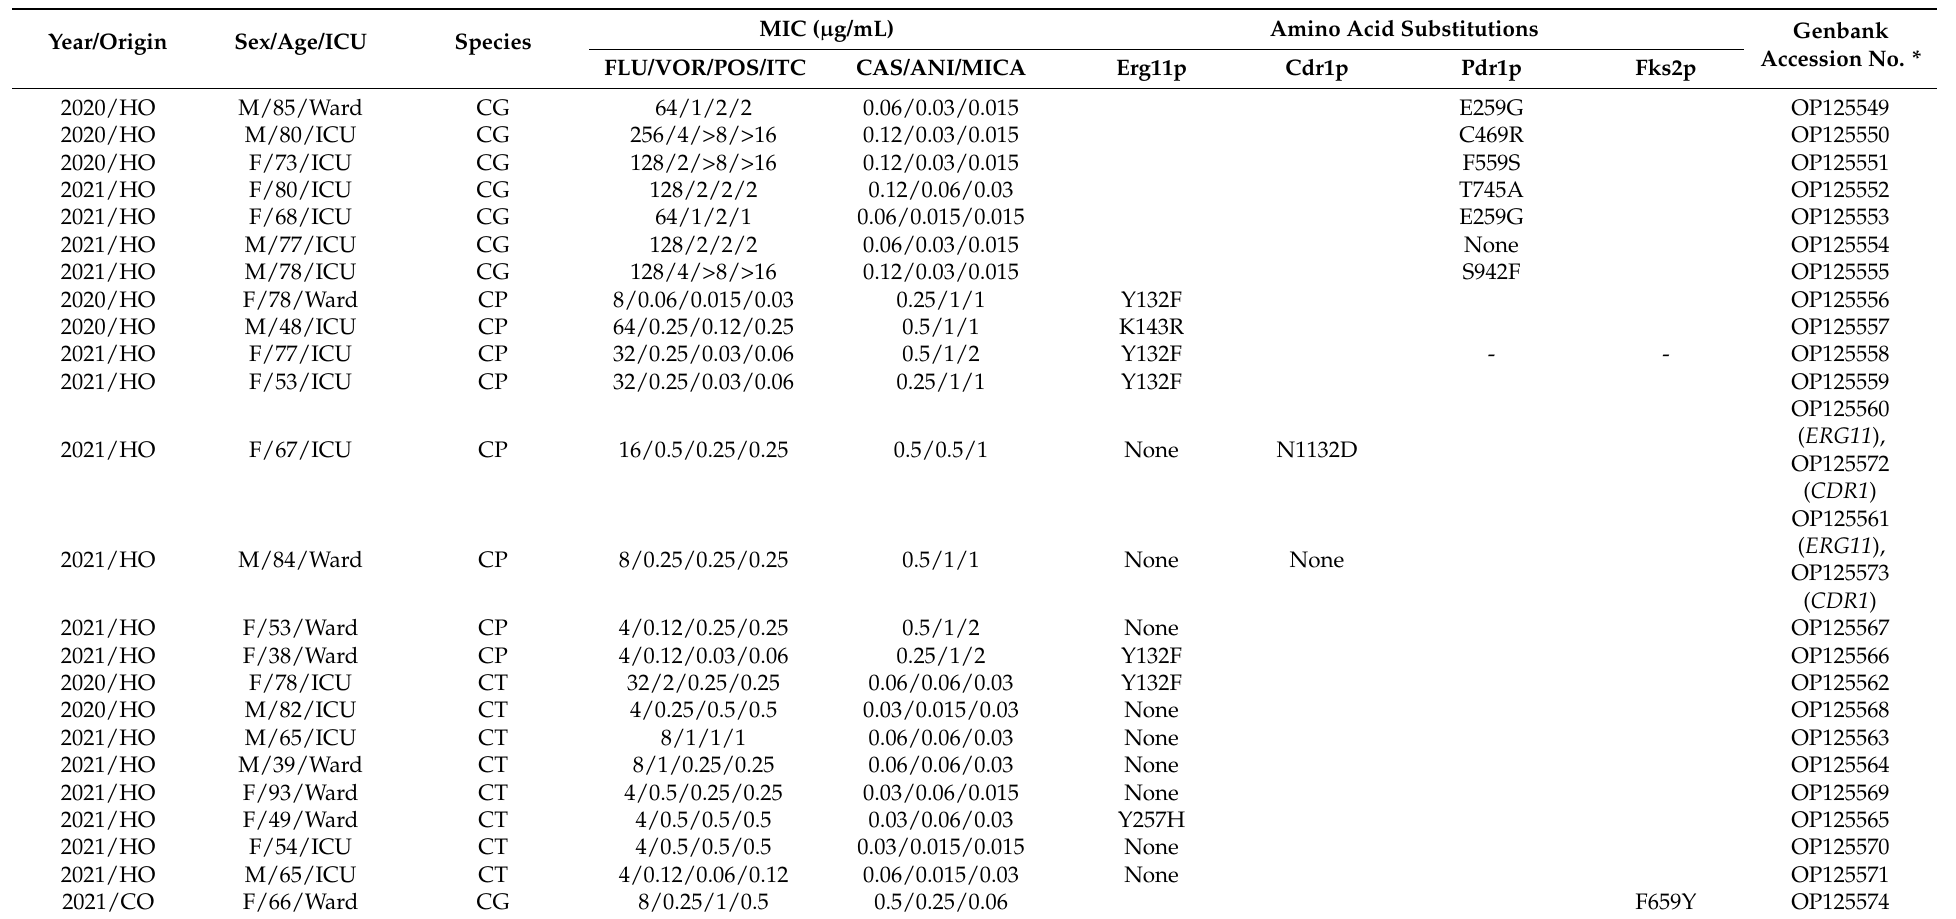
Table 5. Antifungal resistance mechanisms of 24 fluconazole or echinocandins resistant or non-susceptible Candida bloodstream isolates obtained from Kor-GLASS surveillance